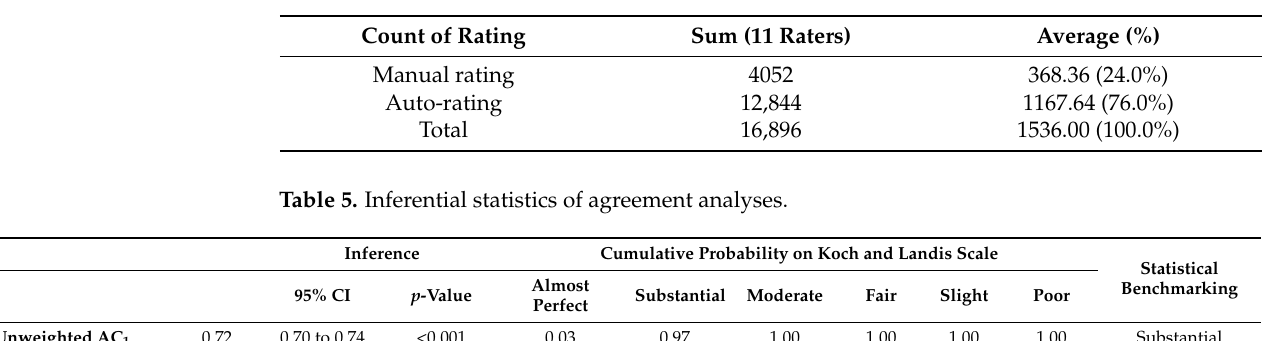
Table 4. Summary of type of rating.